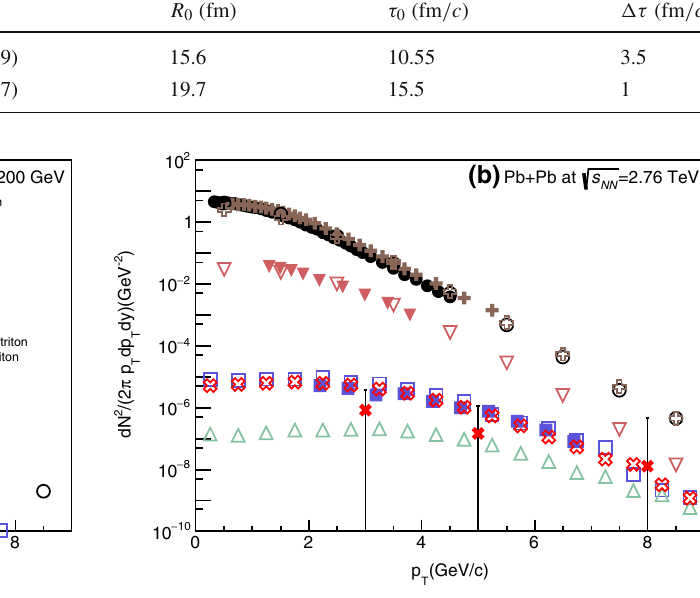
Fig. 3 Transverse momentum p T spectra of p , (cid:3), 3 (cid:2) H , and (cid:3) pn in √ s NN = 200 GeV ( a ) and Pb + Pb collisions Au + Au collisions at √ s NN = 2 . 76 TeV ( b ). The open markers for p , (cid:2) and (cid:3) directly at